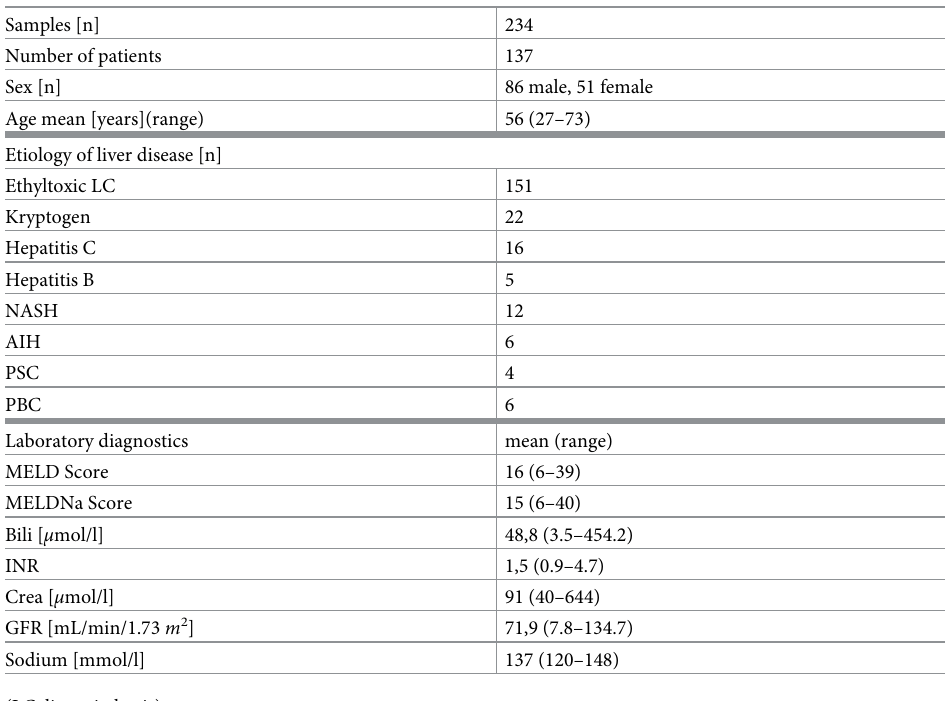
Table 1. Patient